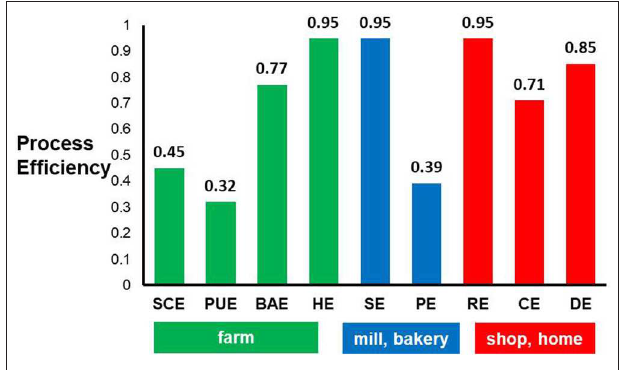
FIGURE 1 | Illustrative case study: estimated processes efficiencies during the production and consumption of bread in the UK. Processes on the farm, mill & bakery, and shop & home are defined and estimated as described in the